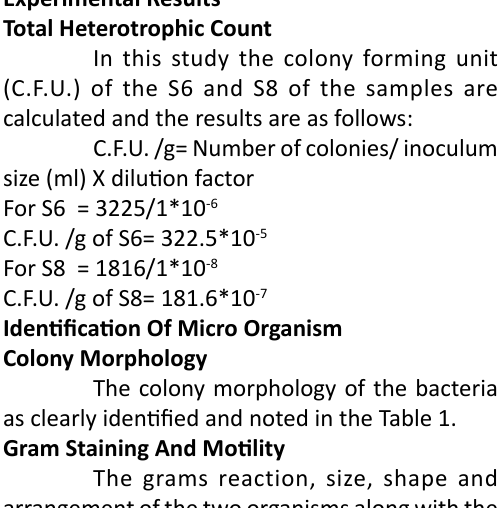
Table 3. Summary of the biochemical tests such as IMVIC and catalase test results are shown Organism